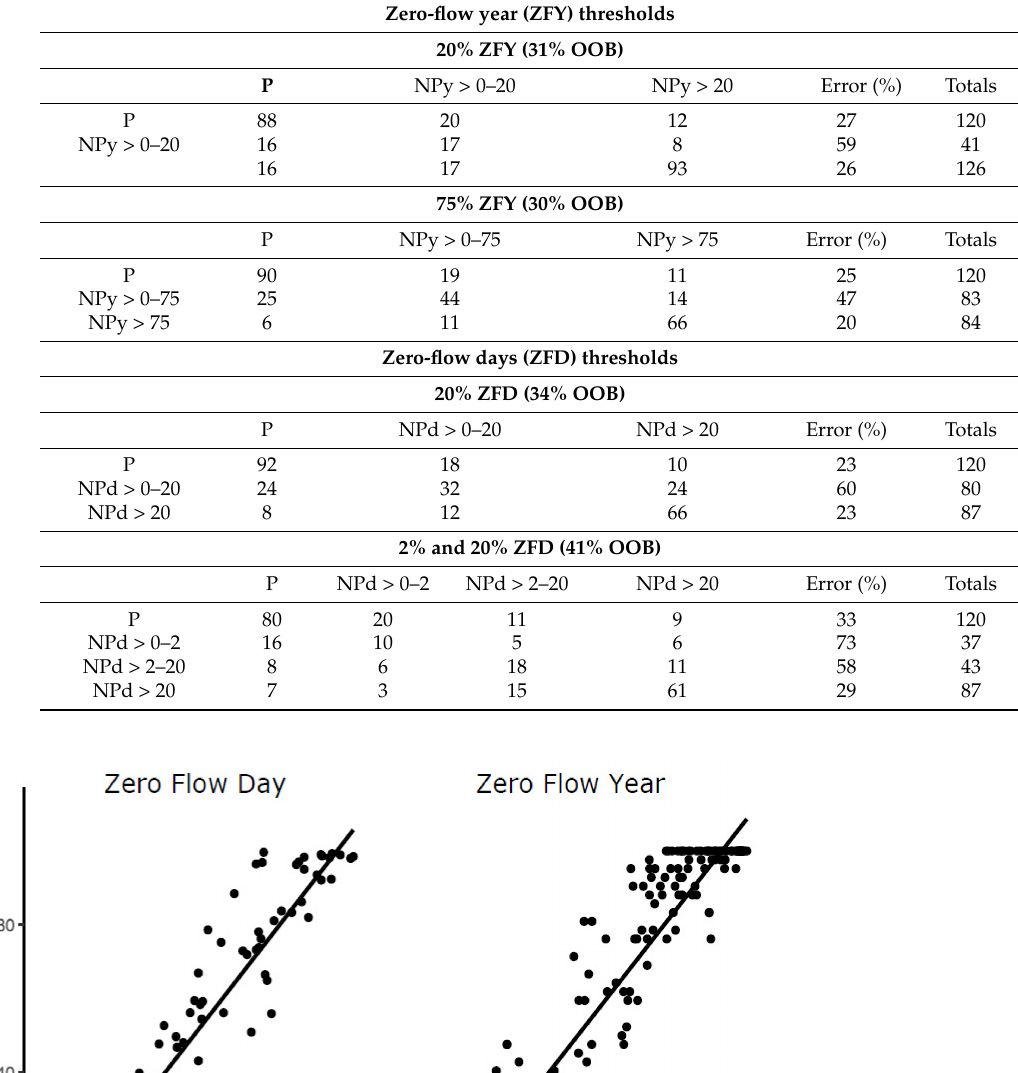
Table 5. Confusion matrices for the four percent zero-flow day and percent zero-flow year threshold classification models. P = perennial reaches (equal to 0% ZFY or ZFD); NPy>0–20 = > 0 but <20%